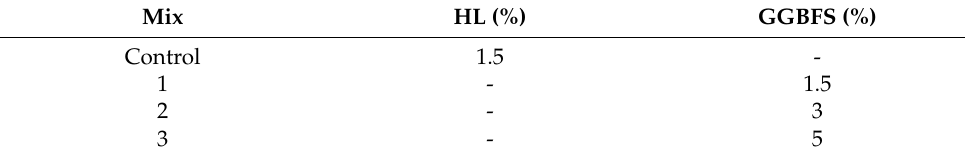
Table 6. Asphalt